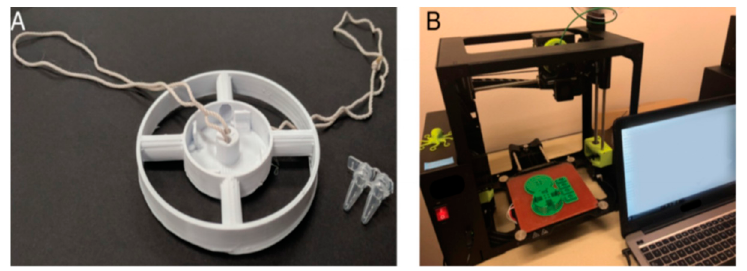
Figure 6. The production of 3D-Fuge. ( A ) Physical picture of a 3D-Fuge. ( B ) Printing of a 3D-Fuge. Reprinted with permission from [84]. Copyright 2019 Public Library of Science.